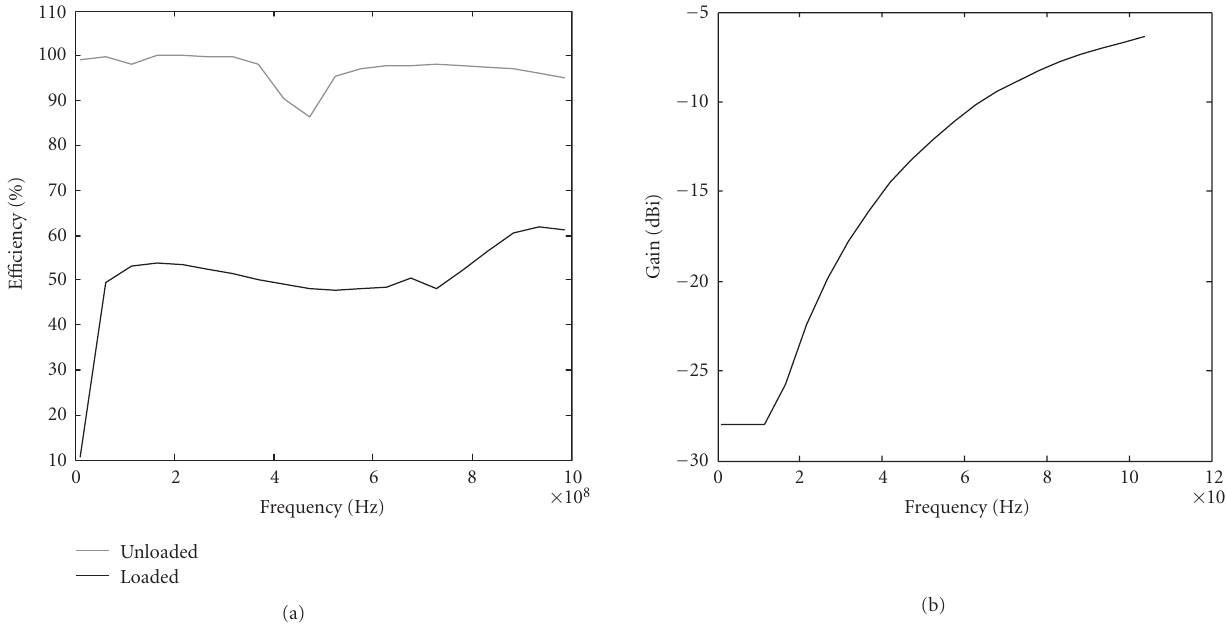
Figure 13: Simulated antenna e ffi ciency and gain (a) simulated antenna e ffi ciency, (b) simulated antenna